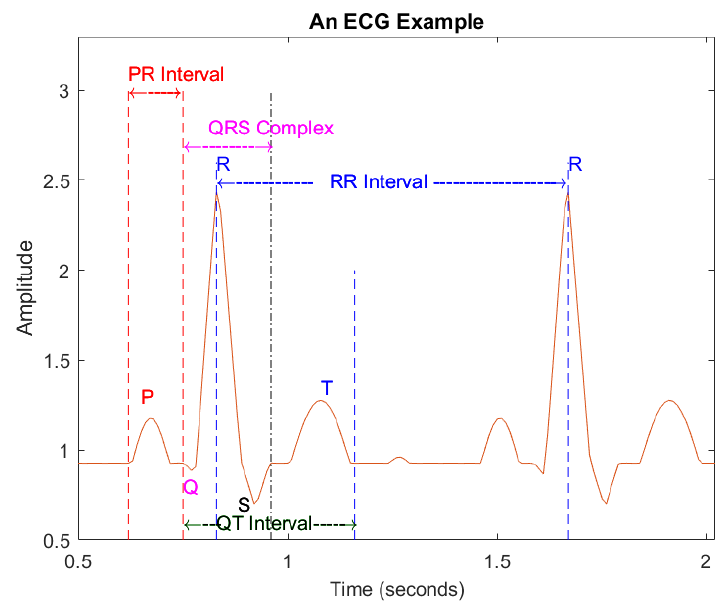
Figure 3. An example of ECG signals.